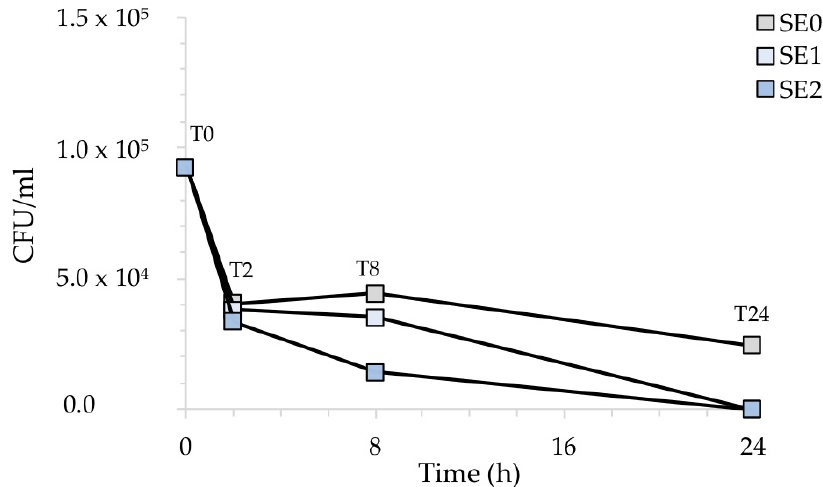
Figure 7. CFU/mL recovered after the exposure of the silver-treated contaminated surfaces to S. aureus with respect to the untreated control. The results are representative of three independent determinations.